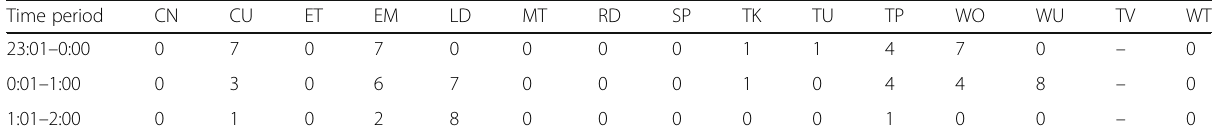
Table 16 Time – activity table for workdays (Monday, Wednesday, to Friday) for eButton wearer 2 (Continued)